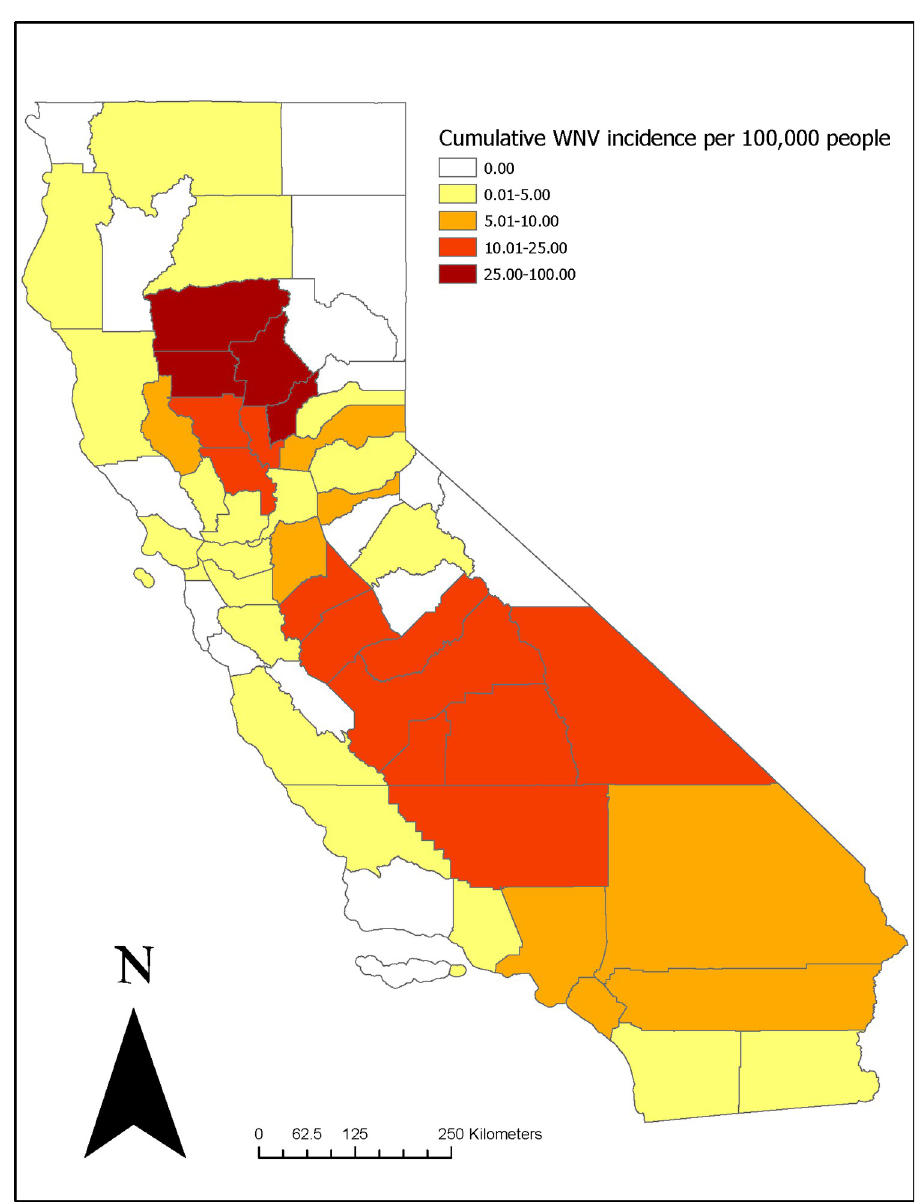
Fig 2. Human West Nile virus (WNV) cumulative incidence in California by county, 2015–2020. County data courtesy of U.S. Census Bureau TIGER/line spatial files, 2016. (Shapefile: